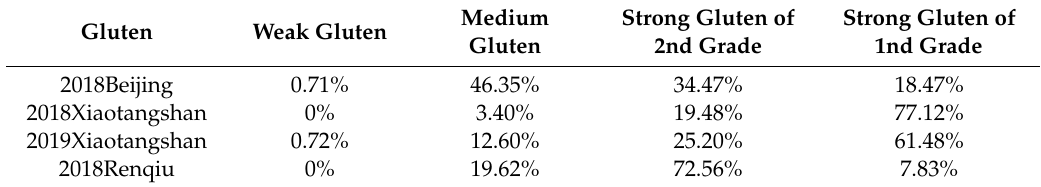
Figure 7. GPC spatial distribution maps of various districts of Beijing in 2018: ( a ) Shunyi; ( b ) Changping; ( c ) Daxing; ( d ) Yanqing; ( e ) Pinggu; ( f ) Fangshan; ( g ) Tongzhou; ( h ) Huairou, and Miyun. The extended map of b is the GPC monitoring map of Xiaotangshan. Table 6. Statistics of wheat area with di ff erent gluten